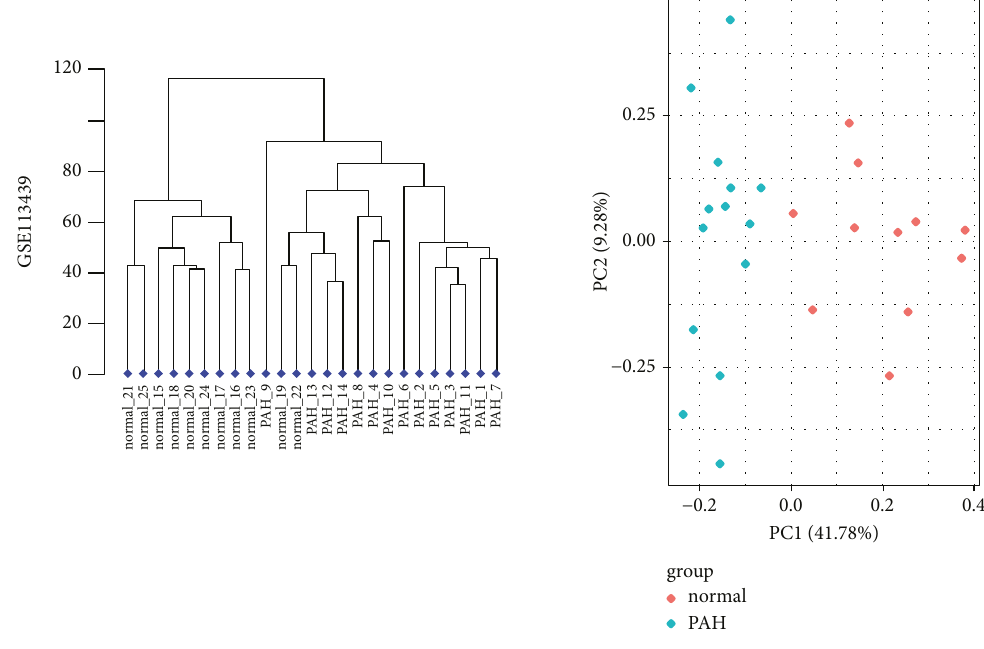
Figure 1: Normalization of gene expression and cluster analysis and PCA analysis for each sample. (a) Normalization of gene expression for GSE53408 data. (b) Normalization of gene expression for GSE113439 data. Abscissa shows sample lists, and ordinates show the gene expression value (log2 transformed). Blue bars represent the data before normalization, and red bars represent the normalized data. (c) Cluster analysis and PCA analysis for each sample of GSE53408 data. (d) Cluster analysis and PCA analysis for each sample of GSE113439 data. The PAH group data and the normal group data are readily distinguished. Abbreviations: IPAH, idiopathic pulmonary arterial hypertension; CTDPAH, connective tissue disease-associated PAH; CHDPAH, congenital heart disease-associated